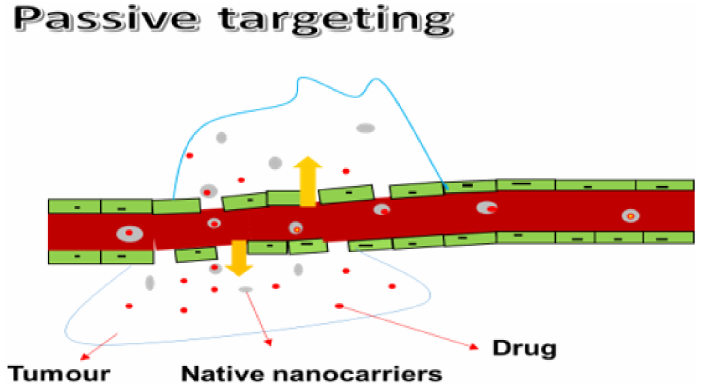
Figure 1. Passive